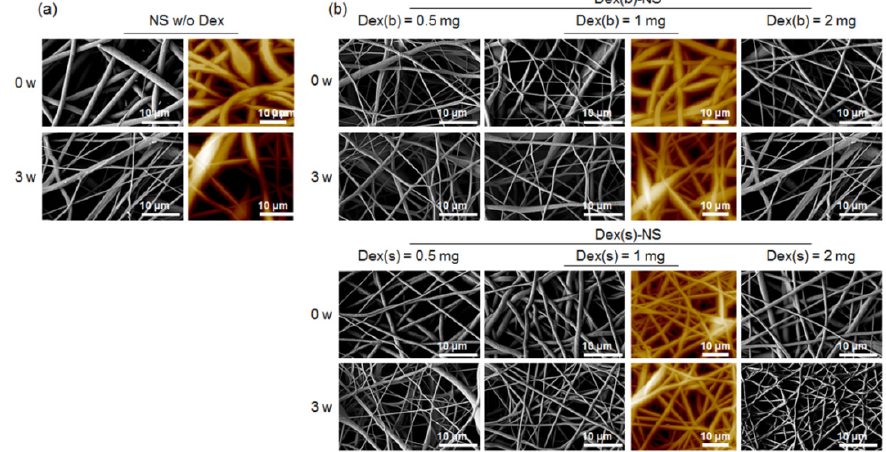
Figure 4. SEM images before and after in vitro biodegradation of ( a ) NS; ( b ) Dex(b) ‐ NS, and Dex(s) ‐ NS with Dex 0.5–2 mg (SEM: 3000 × magnification, AFM: 40 μ m × 40 μ m).